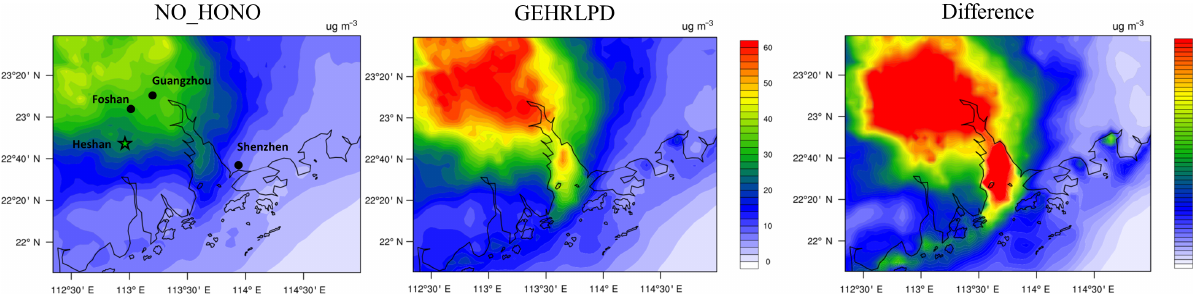
Figure 9. Spatial distributions of average TNO 3 concentrations simulated in the NO_HONO and GEHRLPD cases and their difference for domain 3 during 4–8 January